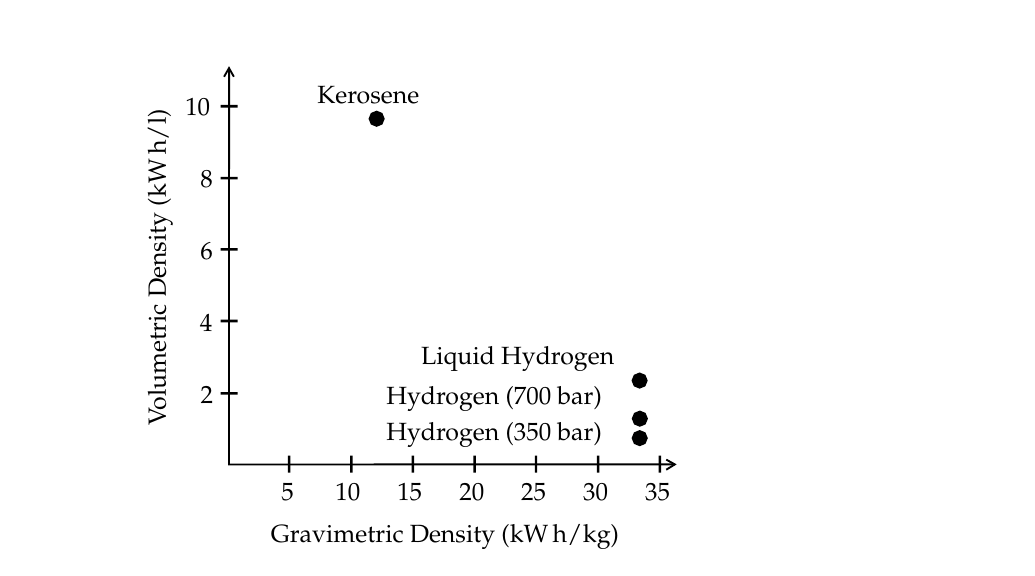
Figure 1. Volumetric and gravimetric density comparison between hydrogen and kerosene, data from Office of Energy Efficiency & Renewable Energy